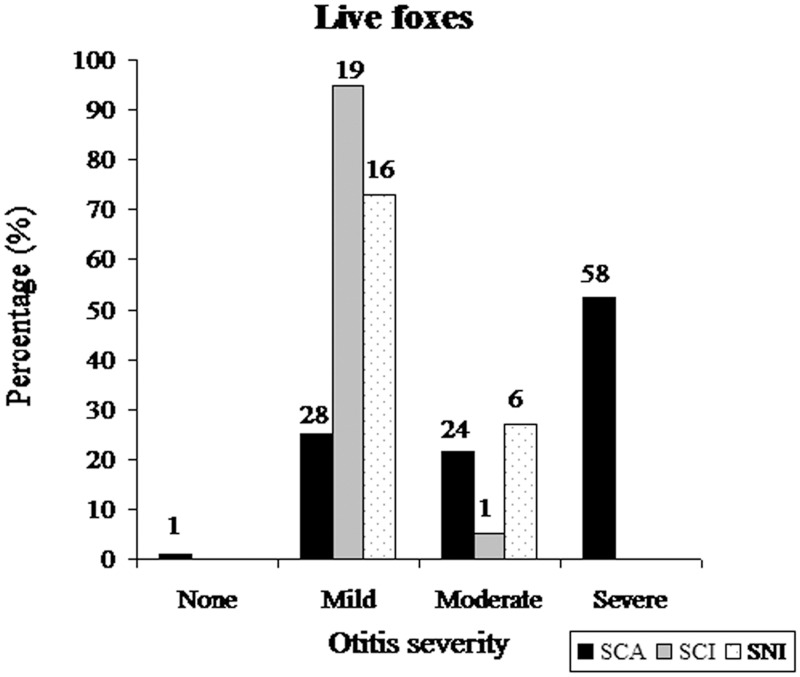
The frequency distribution of otitis severity scores in biopsy-sampled live adult foxes from SCA, SCI, and SNI.Number above bar equals sample size for each subgroup.